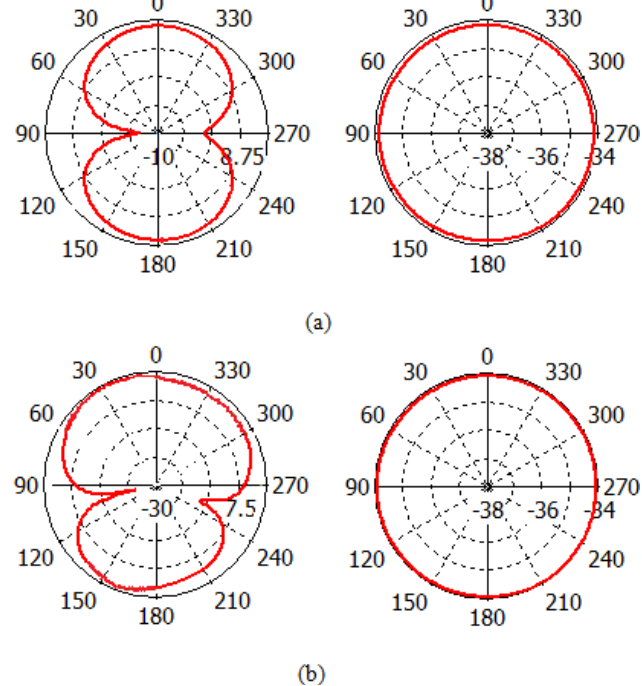
Figure 16. Simulated far-field radiation patterns of the proposed antenna at: (a). 2.4 GHz and (b). 5.8